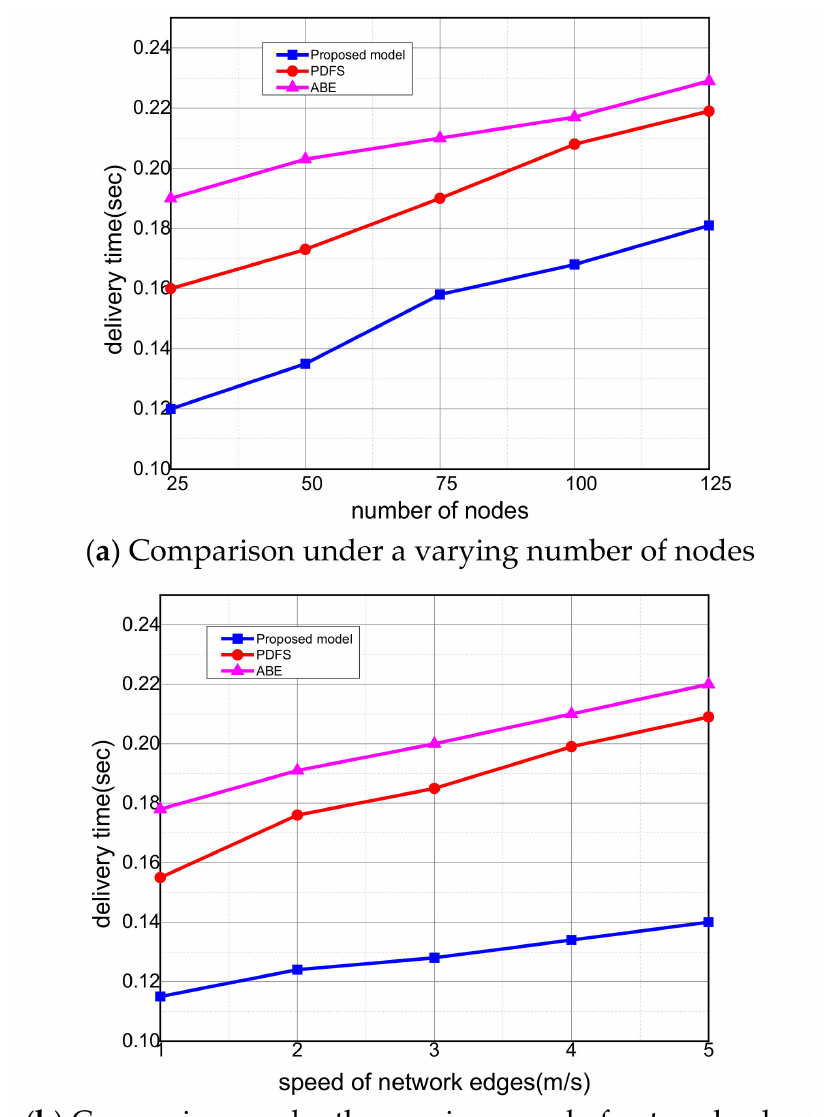
Figure 3. Evaluation of delivery time among proposed model, PDFS, and